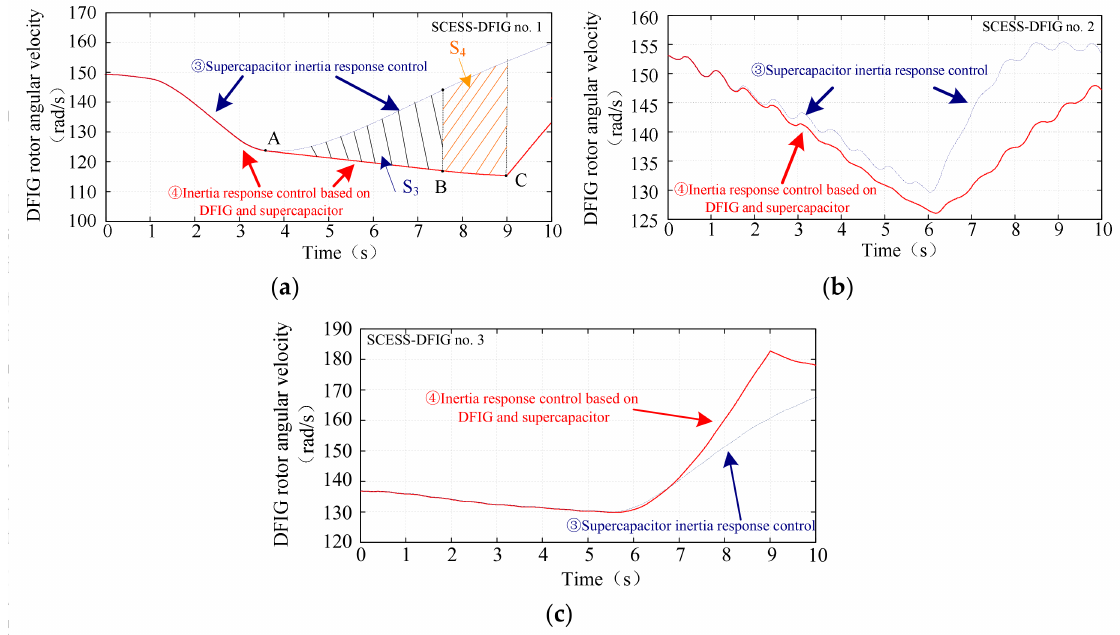
Figure 22. Comparison of angular velocity of the SCESS-DFIG rotor under different control strategies: ( a ) No. 1 SCESS-DFIG angular velocity under different control strategies; ( b ) No. 2 SCESS-DFIG angular velocity under different control strategies; ( c ) No. 3 SCESS-DFIG angular velocity under different control